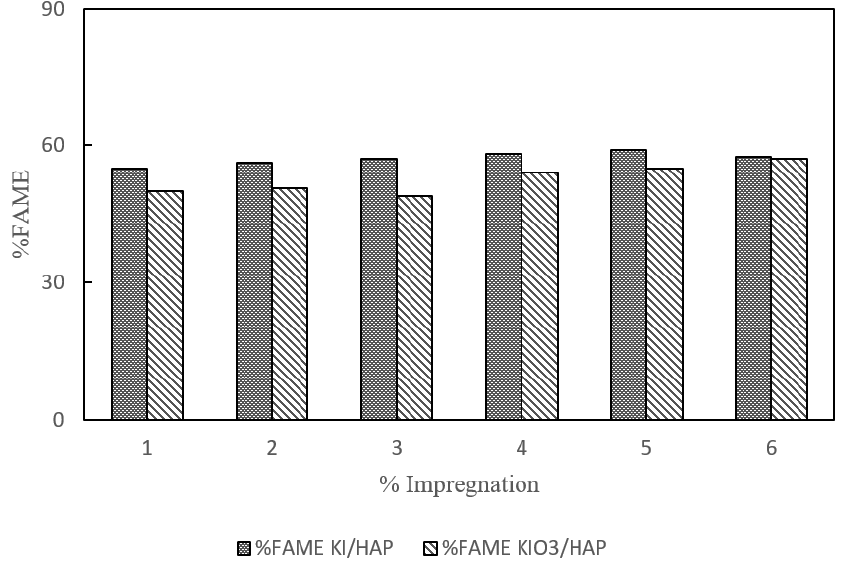
Figure 7. E ff ect of catalyst type on % FAME of biodiesel.